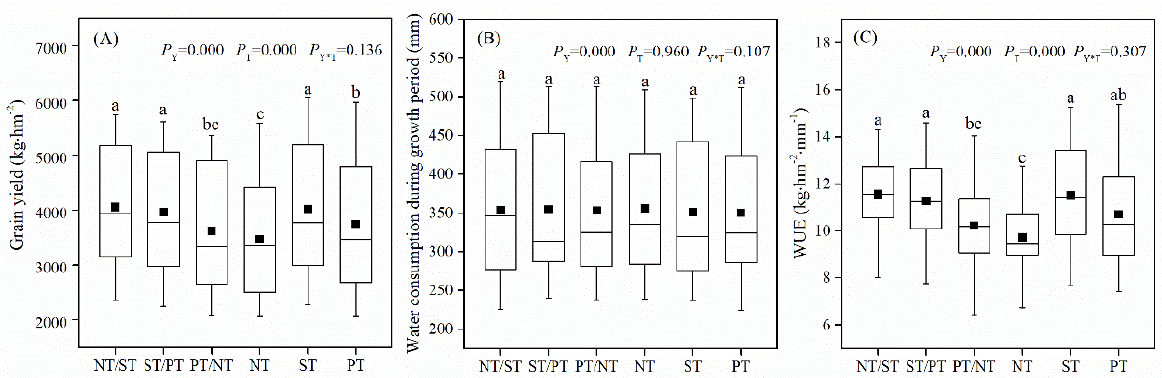
Figure 2. Wheat grain yield ( A ), water consumption during wheat growth period ( B ) and water use efficiency (WUE) ( C ) over eight seasons from 2007 to 2015. Different lowercase letters mean a significant difference at the 0.05 level among treatments.